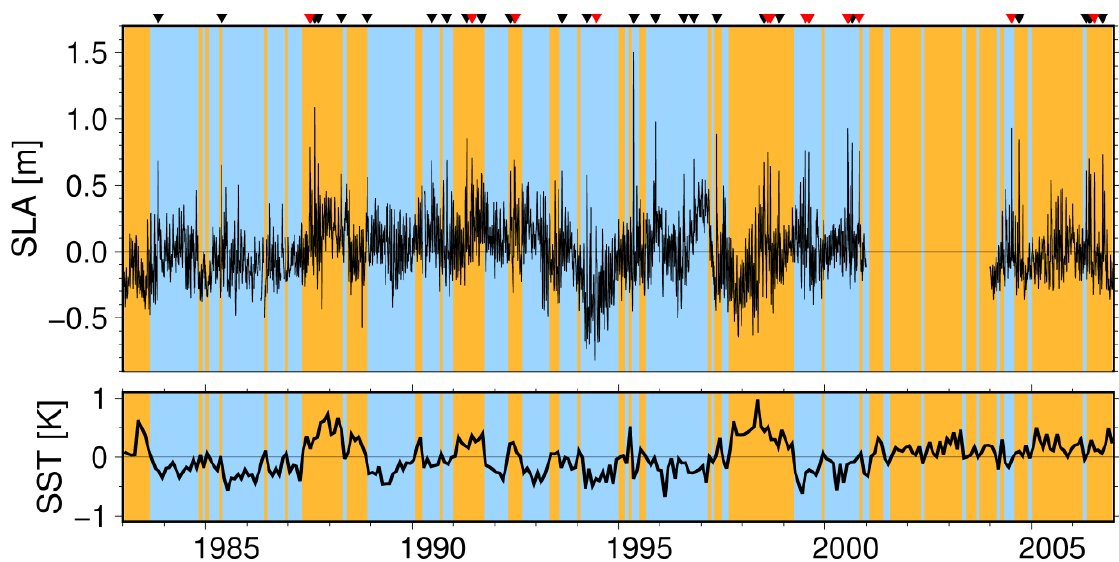
Figure 11. Time series of (upper) daily SLA at Cox’s Bazar and (lower) monthly mean SST anomaly over the Bay of Bengal (5° – 23° N and 80° – 99° E). Shading indicates the period of positive (orange) and negative (blue) SST anomaly. The triangle plotted on the top denotes the day of the ESL event. The red triangle indicates the ESL event at which the R 2 difference was greater than 0.3. The station SLA data are missing during 2001 – 2003.